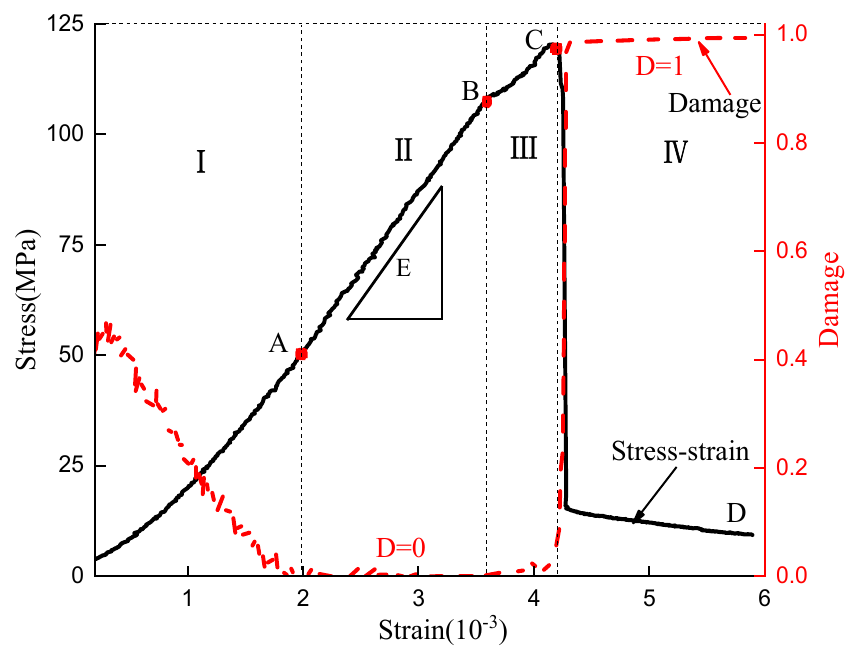
Figure 4. Rock damage evolution curve and stress-strain curve at 25 ℃ .